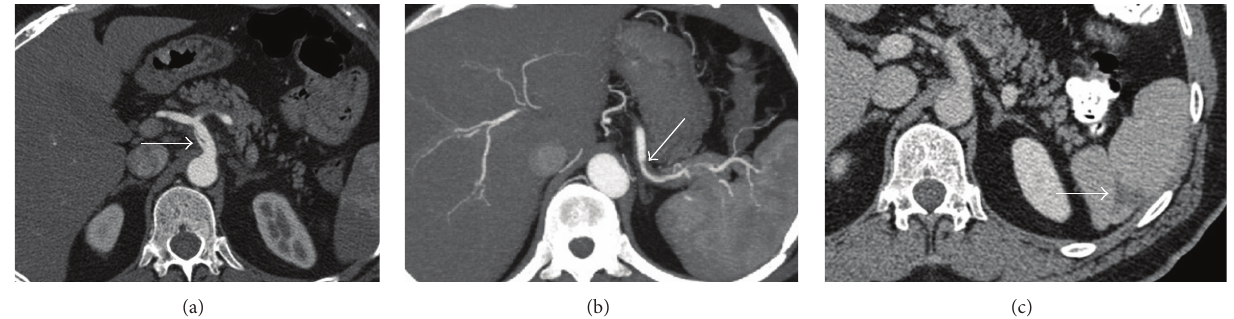
Figure1:AxialenhancedCTscanshows(a)anintimaldissectionoftheceliacarterywithopacificationoftrueandfalselumen,(b)adissection membrane in the splenic artery causing poor contrast flow and thrombosis of the false lumen, and (c) a posterolateral splenic infarction.